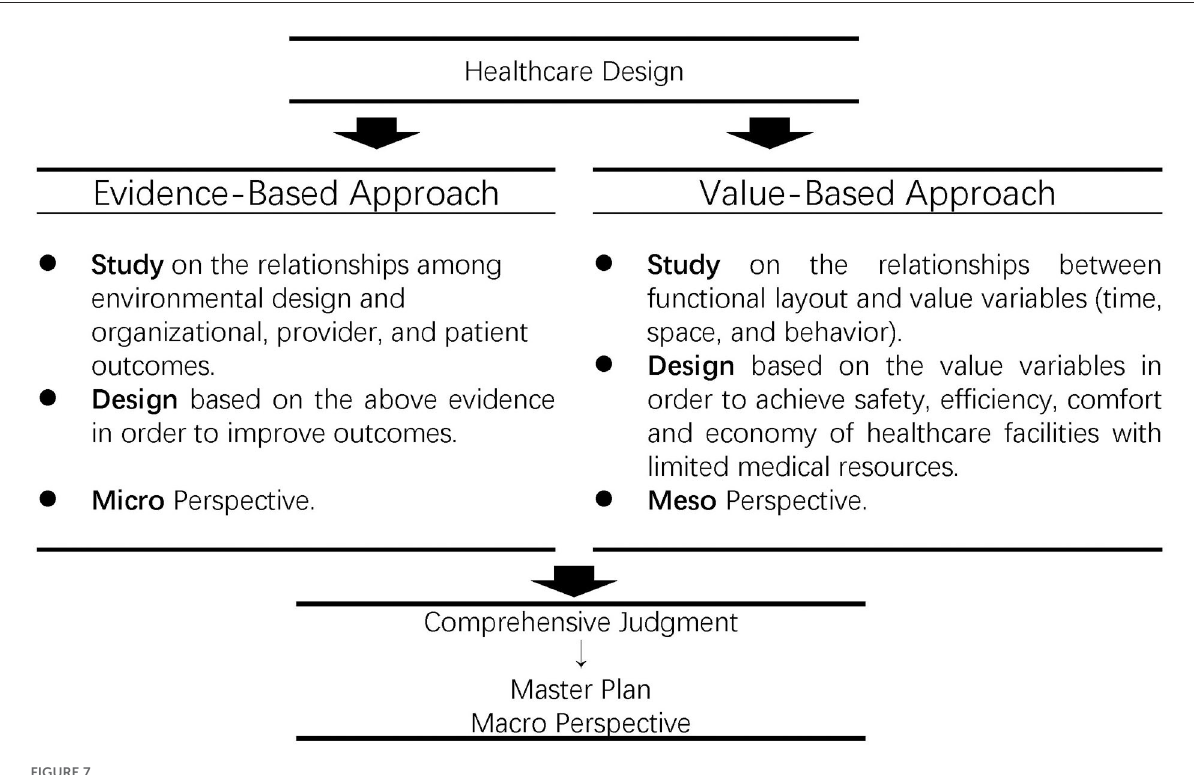
FIGURE7 Conceptual framework of value-based